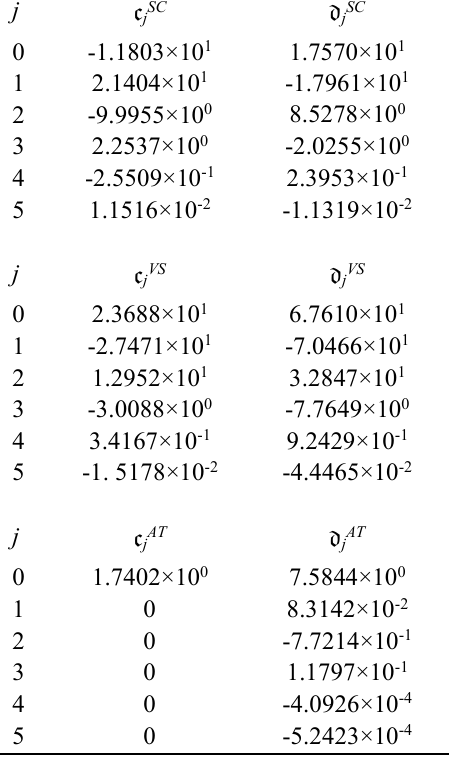
Tab. 2: Coefficients for the conductivity and relative permittivity of the skin layers for 1 kHz to 1 MHz; the skin has been soaked with a 0.9% NaCl solution for 1 minute